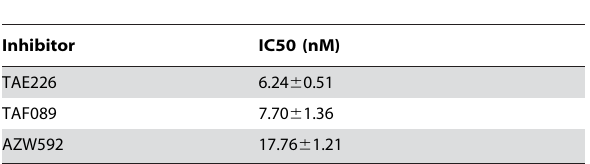
Table 2. IC50 values for FAK